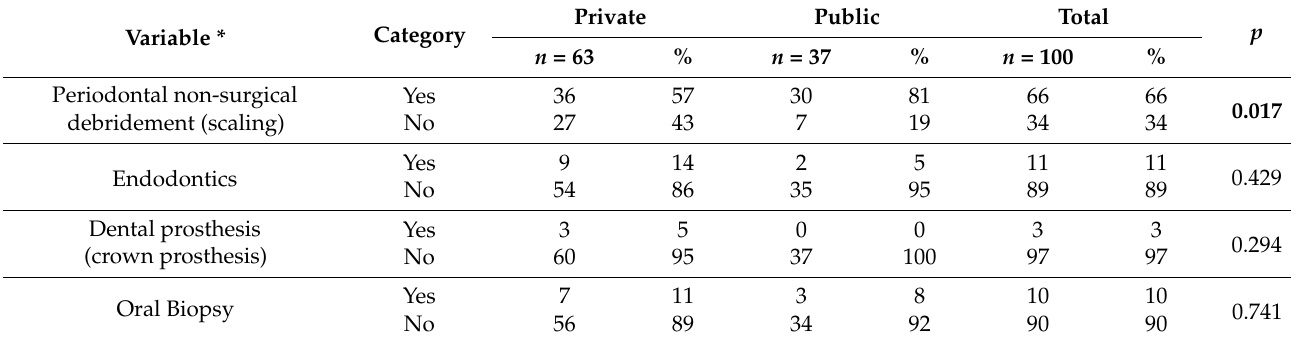
Table 8. The other dental procedures carried out under